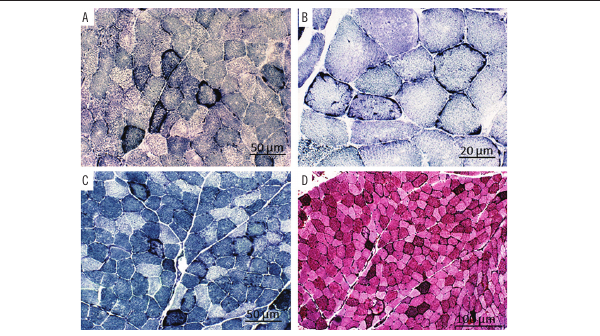
figurE 4 − Ragged blue fibers, SDH hyper-reactive or simply SDH+ fibers are shown in A and B. NADH-TR hyper-reactive fibers are shown in C, but they are less specific due to mitochondria and sarcoplasmic reticulum stain activity. ORO hyper-reactive fibers with intense lipid droplets are shown in D SDH: succinate dehydrogenase; NADH-TR: nicotinamide adenine dinucleotide tetrazolium reductase; ORO: Oil Red O.